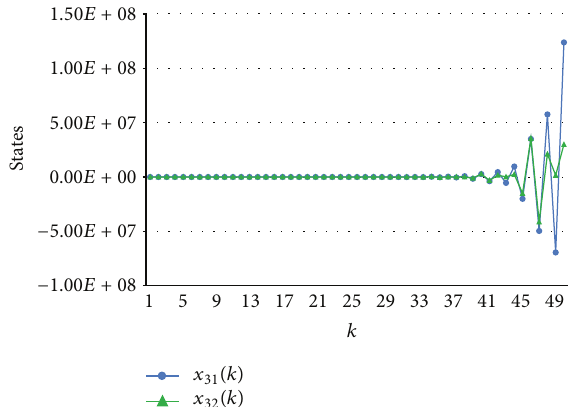
Figure 6: States respond of subsystem 3, 𝑥 31 (𝑘) and 𝑥 32 (𝑘) under feedback control, without discrete-time integral VSC.